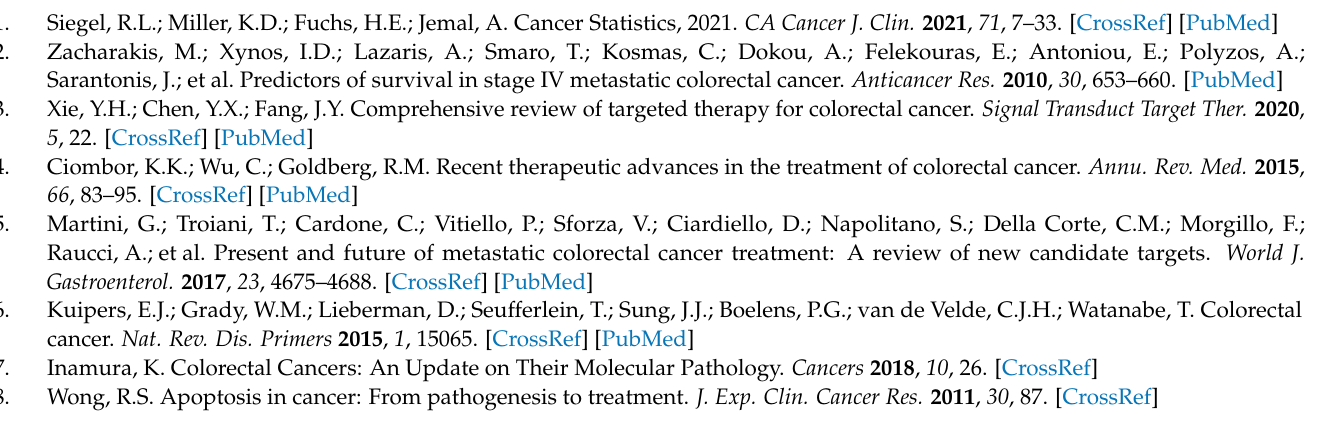
synergizes with TRAIL., Figure S3: Activating DR5 induced by AF8c regulates the Nrf2/Keap1 pathway., Figure S4: Nrf2 increase by AF8c is regulated by Keap1., Figure S5: AF8c induces DR5 and Nrf2 activation through ER stress in PDC cells, leading to apoptosis. Figure S6: Original Western blot